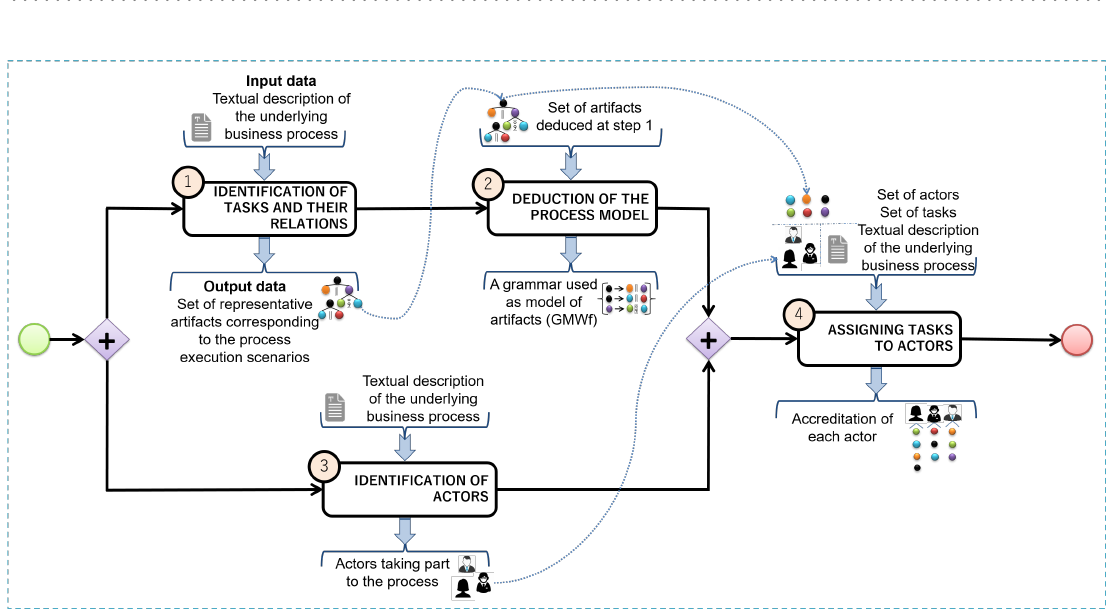
Figure 3: The main activities that are carried out when modelling a process using